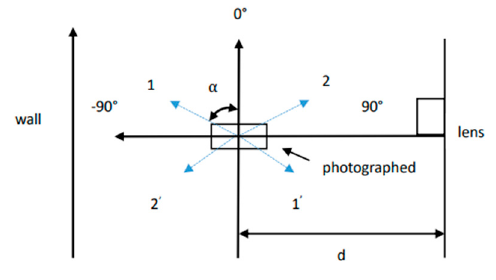
Figure 4. The translational motion of the human ear. Table 5. Human ear database information of Eardata2.